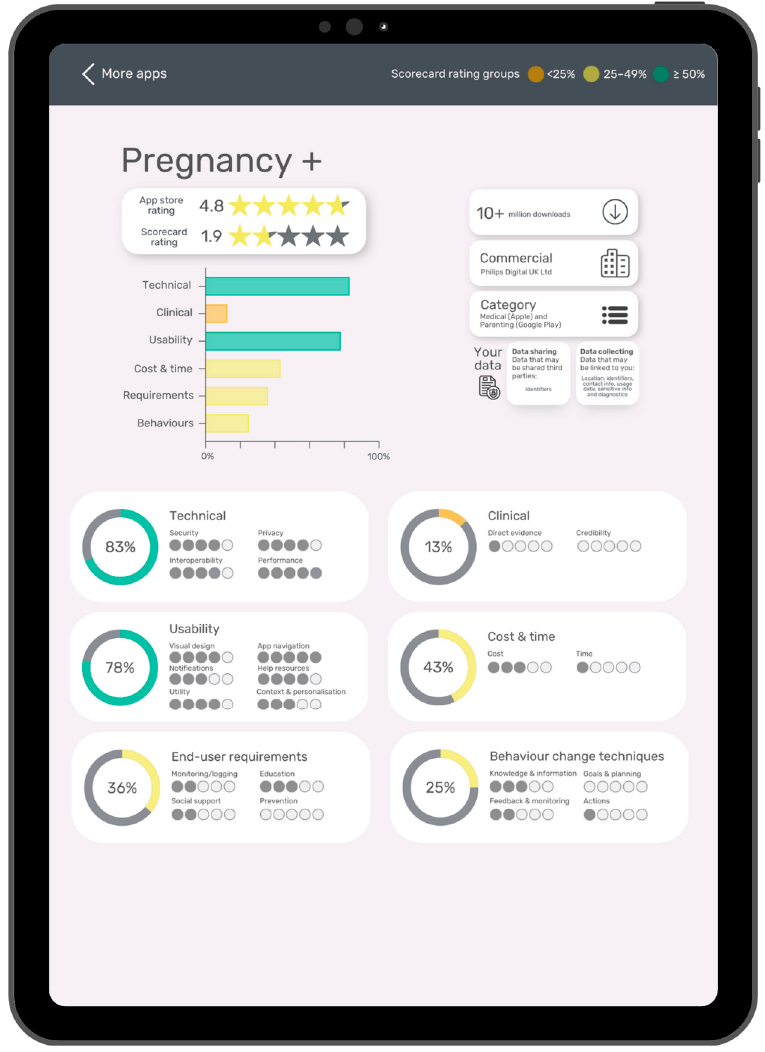
Figure 6. Digital health scorecard: proposed user interface (UI) on a tablet device using the Preg- nancy+ app as an example. The global app store rating is listed with the overall scorecard rating (domain and behaviour change technique (BCT) score)). The breakdown of domain and BCT scores is listed below (technical, clinical, usability, cost and time, end-user requirements, and BCTs.